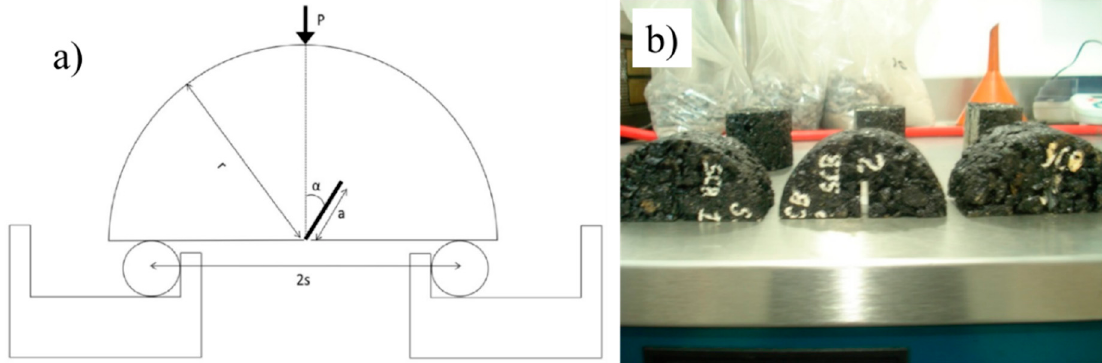
Figure 3. ( a ) Schematic configuration of the semicircular bend (SCB) test and ( b ) geometry of the SCB specimens.